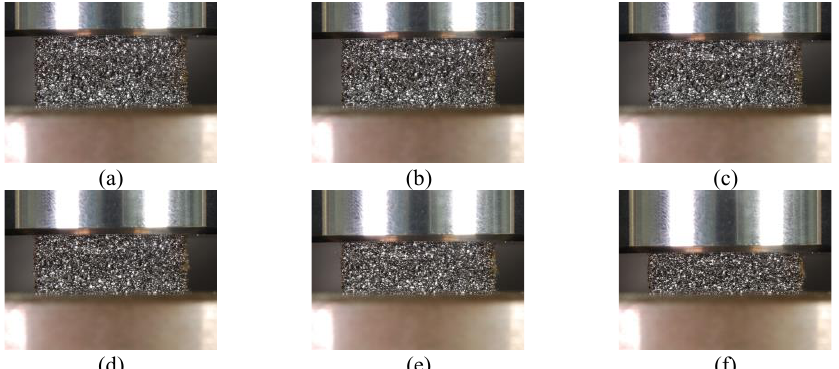
Fig. 3. Deformed test piece in quasi-static test in the case of expansion ratio of 12; at engineering strain of (a) 0.04, (b) 0.07, (c) 0.10, (d) 0.20, (e) 0.30, (f)